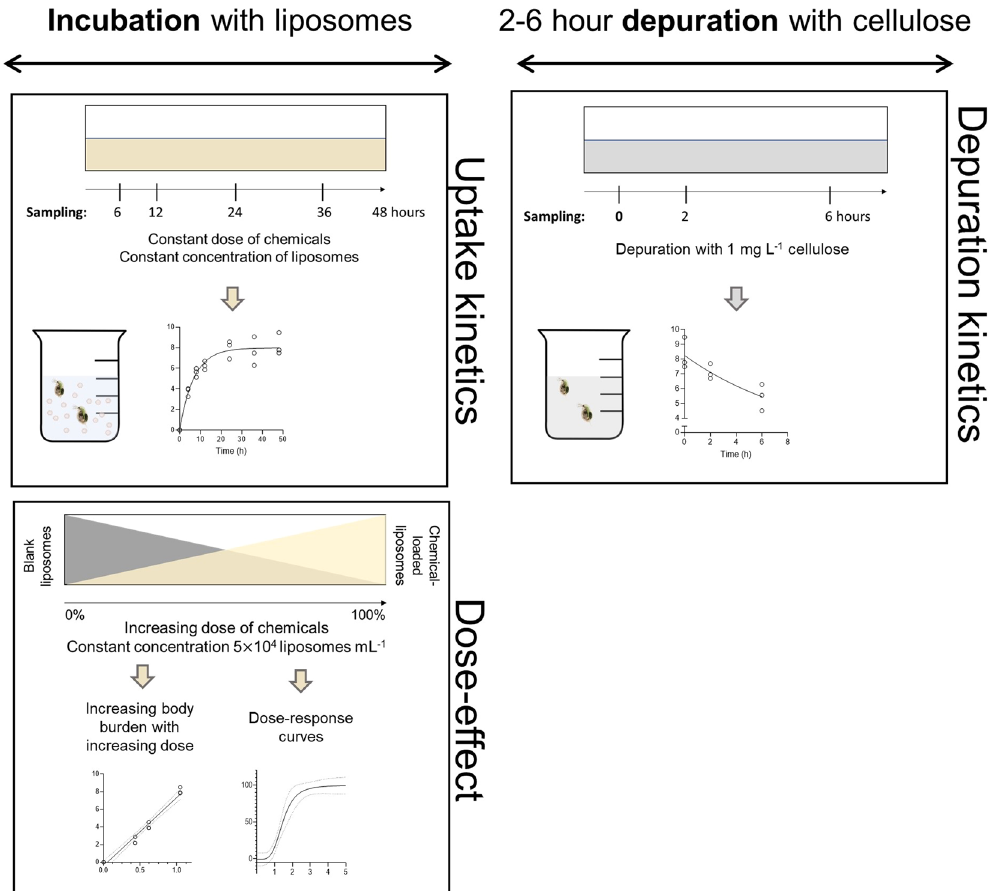
Figure 4. Illustration of the experimental design of the body burden and immobilization experiments. The uptake (exposure) phase lasted 48 hours and was followed by the depuration (post-exposure, 2 to 6 hours) phase. Uptake kinetics of liposome-mediated delivery of chemicals to D. magna were determined by sampling D. magna between 4 to 48 hours of incubation (left panel). Dose-effect (i.e., dose-body burden and dose- response) relationships where obtained by using increasing ratios of chemical loaded liposomes (% of total liposomes, bottom panel). Depuration kinetics were determined by moving exposed daphnids to liposome-free media and allowed to depurate with cellulose (right